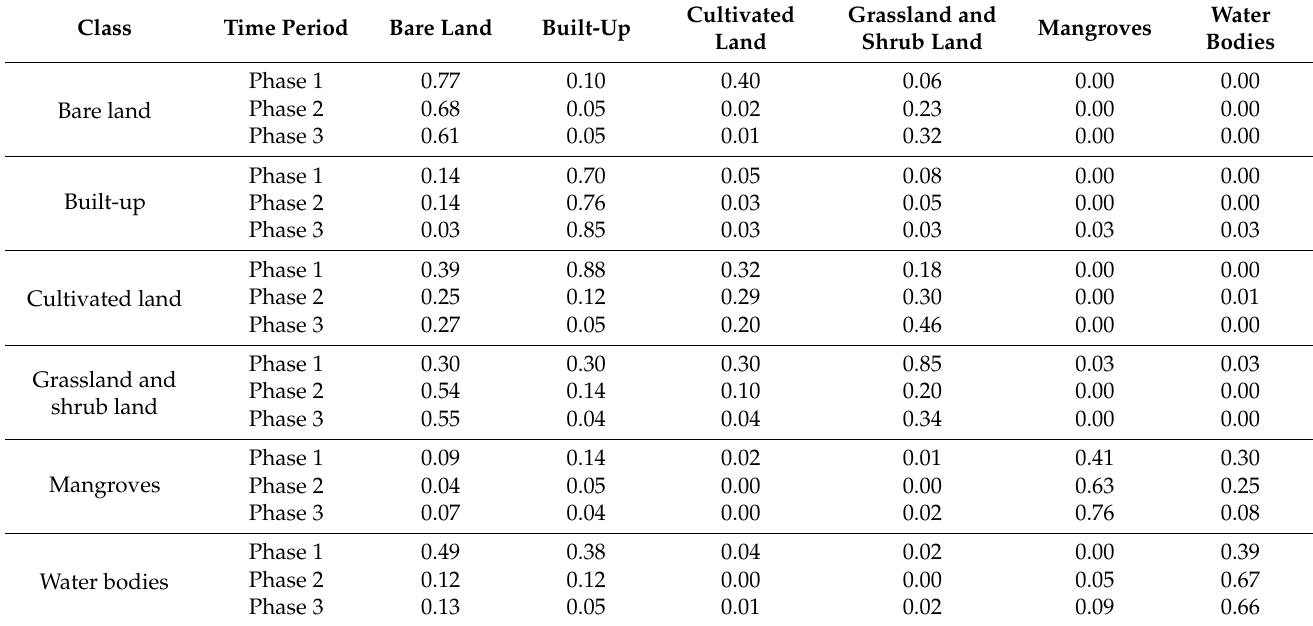
Table 8. Transition probability matrix of LULC classes in Karachi from 1990 to 2000, 2000 to 2010, and 2010 to